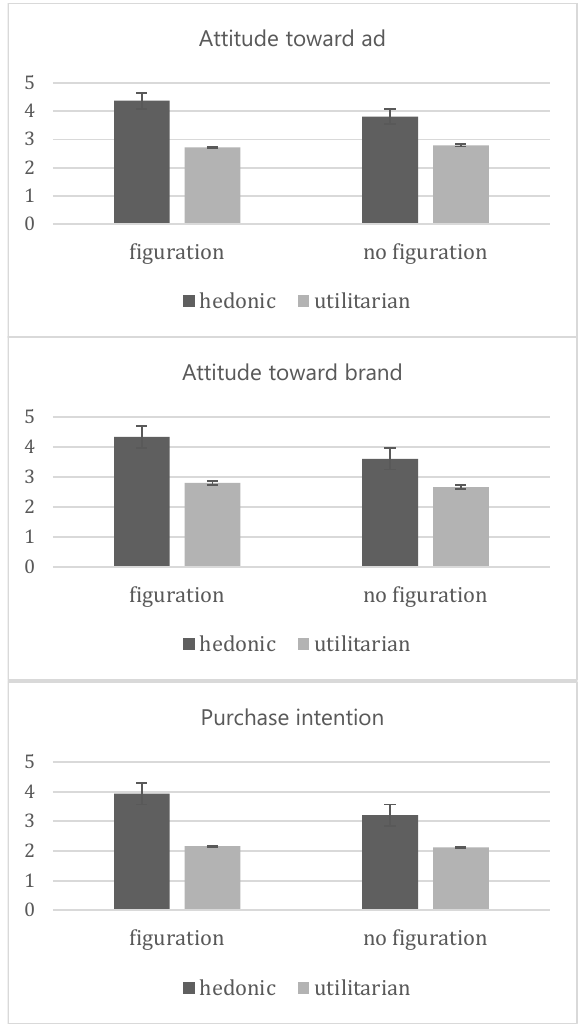
Figure 5. Attitude (Scale measure) as the function of typeface figuration and product type (condition: hedonic vs.